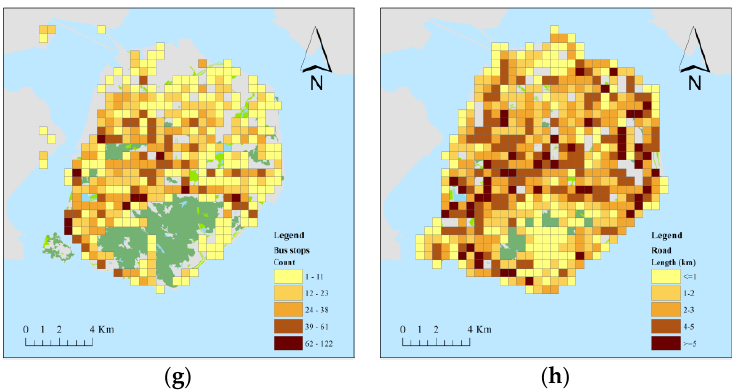
Figure 5. Spatial distribution of different explanatory variables. ( a ) Residential; ( b ) commercial; ( c ) employment; ( d ) public services; ( e ) hotels; ( f ) attractions; ( g ) bus stops; and ( h ) road density.